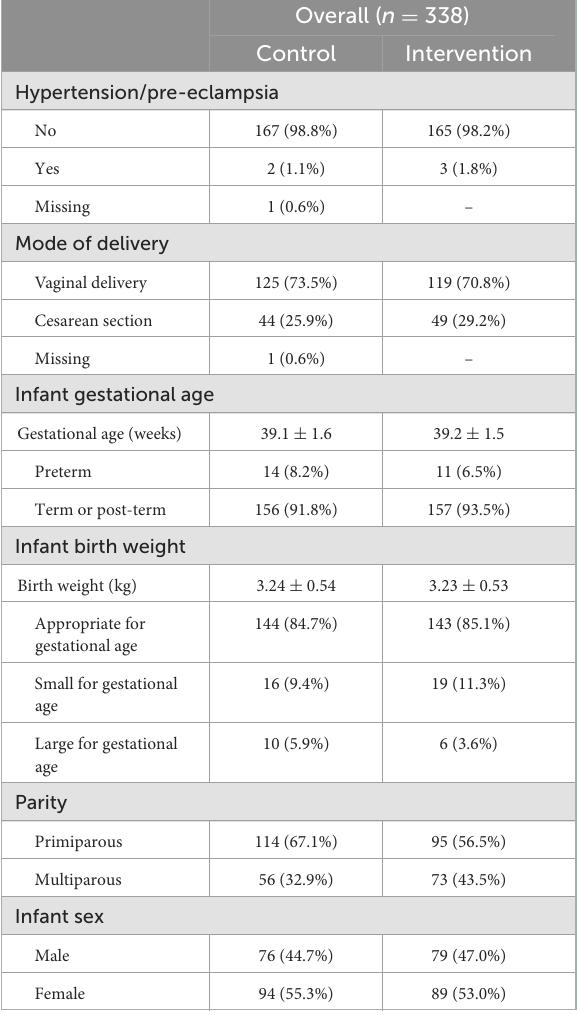
TABLE 4 Baseline and perinatal characteristics of participants in the NiPPeR study who provided at least one human milk sample in 12 months of